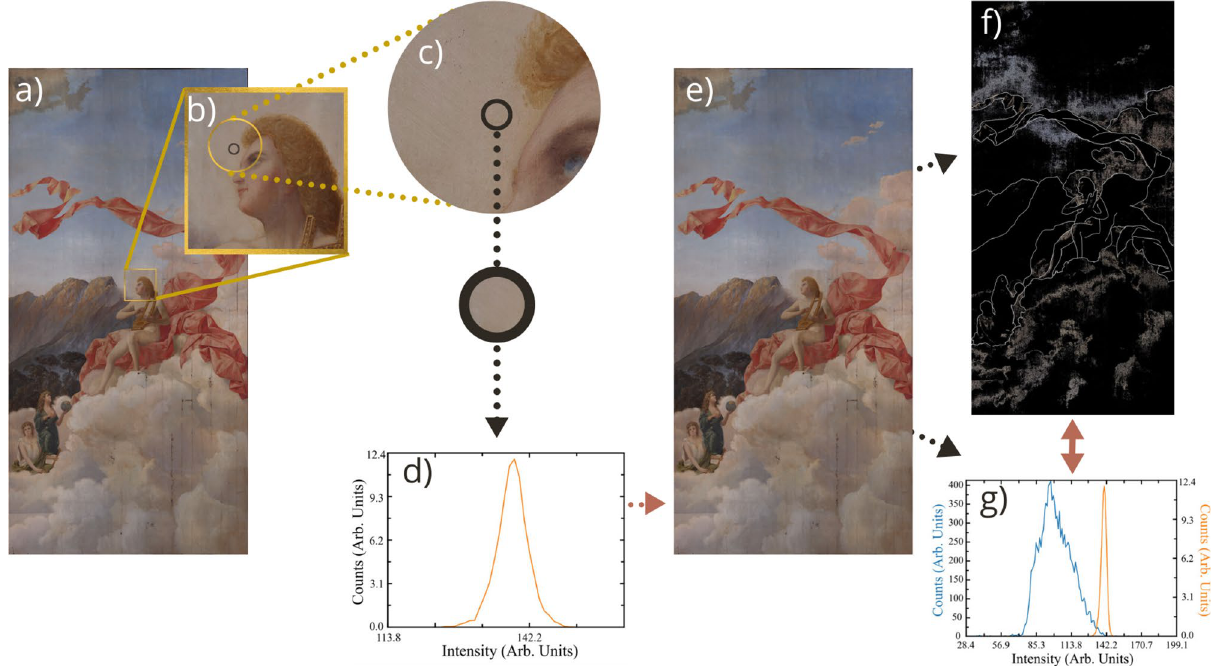
Figure 3. A closer look: Execution of RegionOfInterest software. ( a ) The program opens the image for general user inspection. ( b ) In the first stage, the user zooms in on a region of interest. ( c ) The user hand-draws a contour to select the area for analysis. ( d ) The program converts the selected pixels from HSV to Intensity space and automatically generates a “Counts vs Intensity” histogram indicating pixel intensity distribution ranging from 0 to 255. ( e ) In the second stage, the user chooses the range from the first histogram. ( f ) Pixels in the full image that fall within this intensity range are displayed in a new colour image. ( g ) A second intensity histogram is generated, comparing the intensity distribution of all pixels in the original image (blue line) with that of the selected pixels in the new image (orange line). Note that the y-axis shows different scales for the blue and orange curves, left and right,